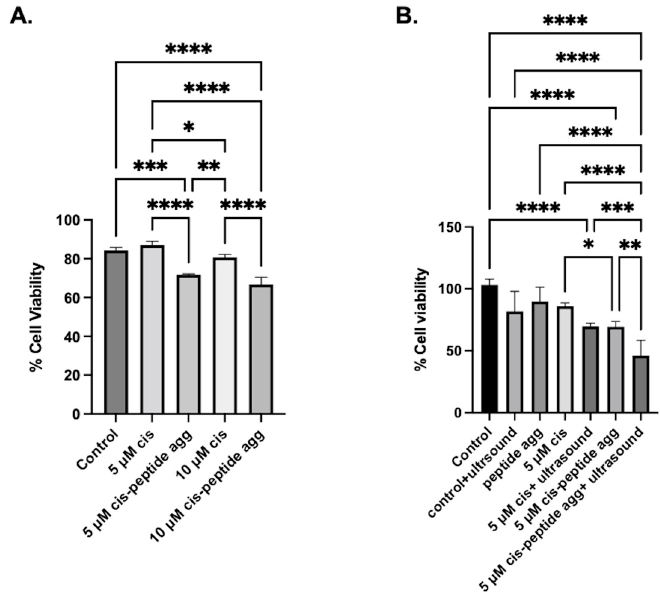
Figure 7. ( A ) LDH toxicity assay of H1299 cells. Cells were treated with 5 µ M and 10 µ M cisplatin alone or encapsulated with RIP1/RIP3 peptide aggregates. Supernatant from the treated cells were treated with LDH reagents, and the absorbance measurements were taken at 490 nm. Control consisted of lysate from control cells in the absence of peptide aggregates or cisplatin. ( B ) Ultrasound-mediated delivery of RIP1/RIP3 peptide aggregates encapsulated with cisplatin significantly improve cellular toxicity. LDH toxicity assay was of H1299 cells treated with cisplatin conditions with and without ultrasound 1.6 W/cm 2 , for 3 min. Controls consisted of lysate from control cells in the absence of peptide aggregates or cisplatin with and without ultrasound. n = 3 ± SEM, * p < 0.05, ** p < 0.01, *** p < 0.001, **** p < 0.0001.